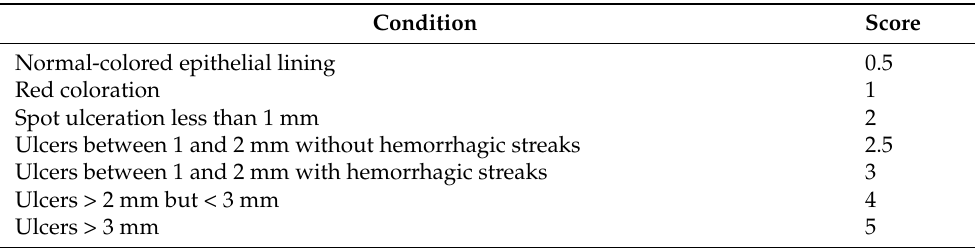
Table 2. Scoring table of the oral ulcers created post-infection of Candida albicans. Condition Score Normal-colored epithelial lining 0.5 Red coloration 1 Spot ulceration less than 1 mm 2 Ulcers between 1 and 2 mm without hemorrhagic streaks 2.5 Ulcers between 1 and 2 mm with hemorrhagic streaks 3 Ulcers > 2 mm but < 3 mm 4 Ulcers > 3 mm